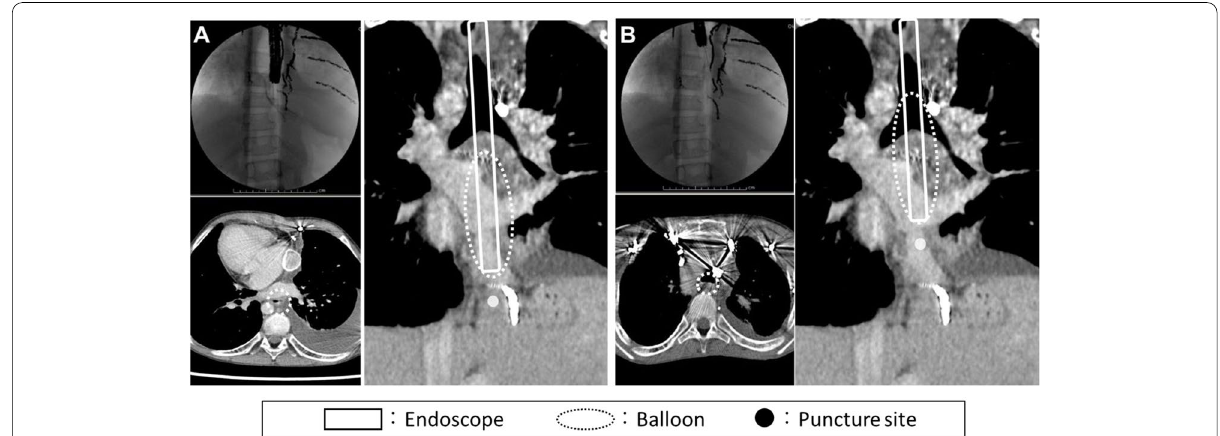
Fig. 2 Intraesophageal balloon position inferred from perioperative CT and fluoroscopic images during injection of sclerotic agents into the varicose vein of the gastric cardia ( A ) and of the esophagus ( B ). Intraoperative fluoroscopic image (upper left), perioperative axial (lower left), and coronal (right) CT images. Note the balloon located behind the common pulmonary venous cavity ( A ) and the coils in front of the tracheal bifurcation ( B